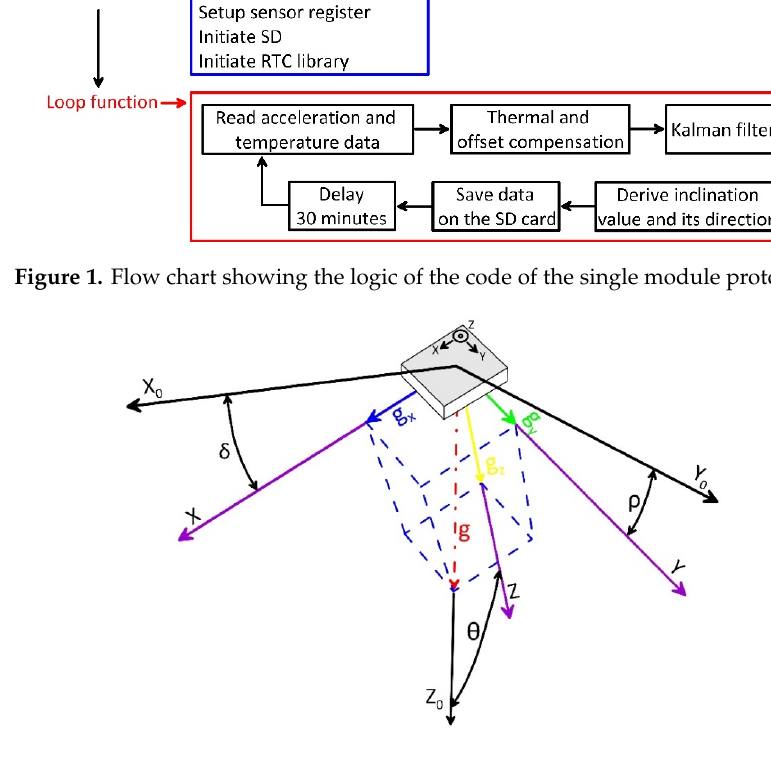
Figure 2. Standards for onboard micro-electromechanical system (MEMS) accelerometer readings and inclination calculation. The blue, green, and yellow vectors are the components of the Earth’s gravity (red dash–dot arrow) measured by each axial accelerometer .